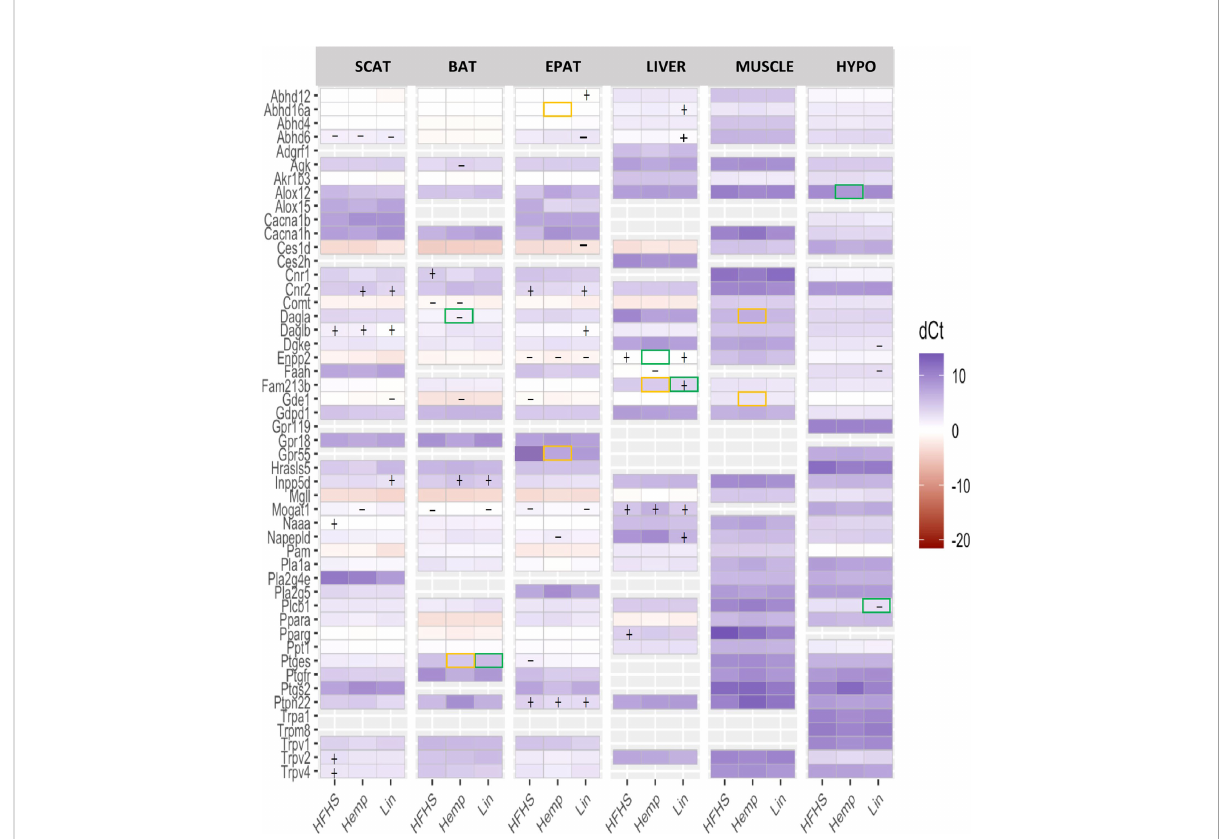
FIGURE 4 eCBome receptor and enzyme expression measured by qPCR array in brown adipose tissue (BAT), epididymal adipose tissue (EPAT), subcutaneous adipose tissue (SCAT), hypothalamus (HYPO), liver, and muscle. Statistically signi fi cant differences between the high-fat high sucrose groups (HFHS, Hemp, or Lin) versus the LFLS group are indicated with a “ + ” (increase in expression) or “ − ” (decrease in expression); p < 0.05. Yellow boxes indicate signi fi cant difference between Hemp and Lin; green boxes indicate signi fi cant differences between Hemp or Lin and HFHS; p <